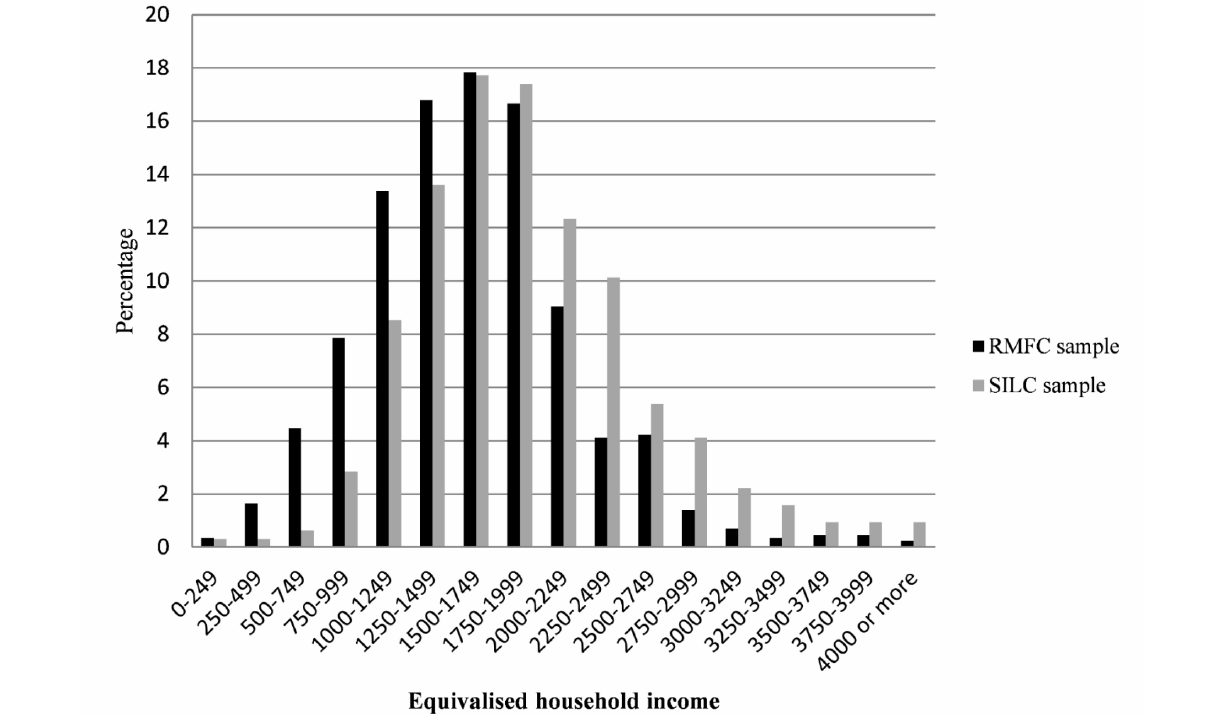
Figure 1. Equivalised household income of the RMFC and the SILC